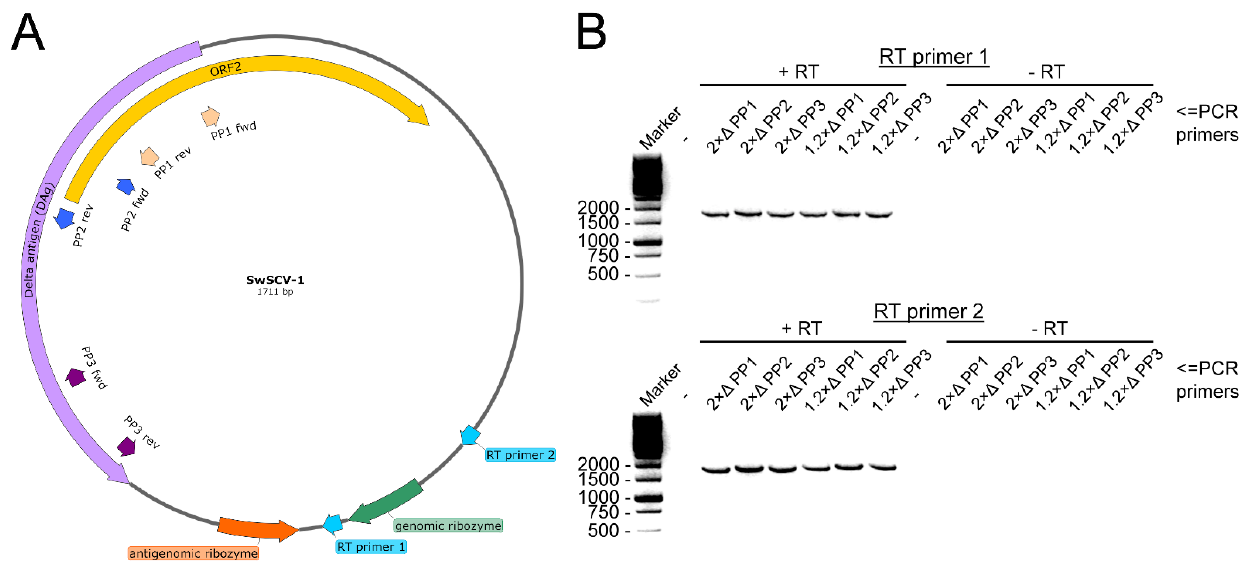
Figure 7. Demonstration of circular SwSCV-1 genome in persistently infected cells using two-step RT-PCR. ( A ) We transcribed cDNA with primers targeting the genomic RNA upstream of either both genomic and antigenomic ribozyme (RT primer 1) or just the antigenomic ribozyme (RT primer 2) to include the putative cleavage sites of the genomic RNA. The subsequent PCR employed three different primer pairs (PP1–PP3) targeting the DAg ORF to amplify the nearly complete SwSCV-1 genome. The figure shows the location of primers in the SwSCV-1 genome map. ( B ) The PCR products with PP1 to PP3 from templates produced from the RNAs extracted from I/1Ki-2× Δ and I/1Ki-1.2× Δ in the presence (left half of both gels) or absence (right side of both gels) of RT enzyme. The top panel shows PCR products with RT primer 1 and the bottom with RT primer 2 separated on 1.2% agarose gel with GelRed for visualization of the bands, the expected size of the amplicons is roughly 1650 nt.